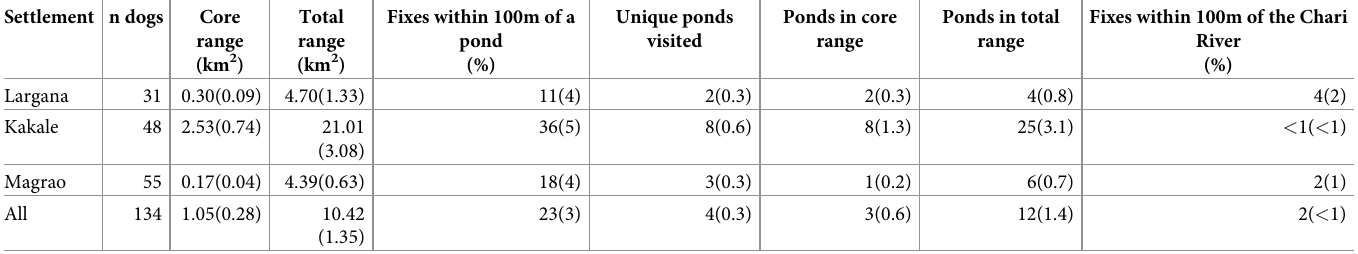
Table 2. Summary of dog ranging behaviour in three settlements in Chad. Core range is the 60% kernel density estimate and total range is the 100% minimum convex polygon. The mean and standard error in parentheses are presented for each variable. Settlement n dogs